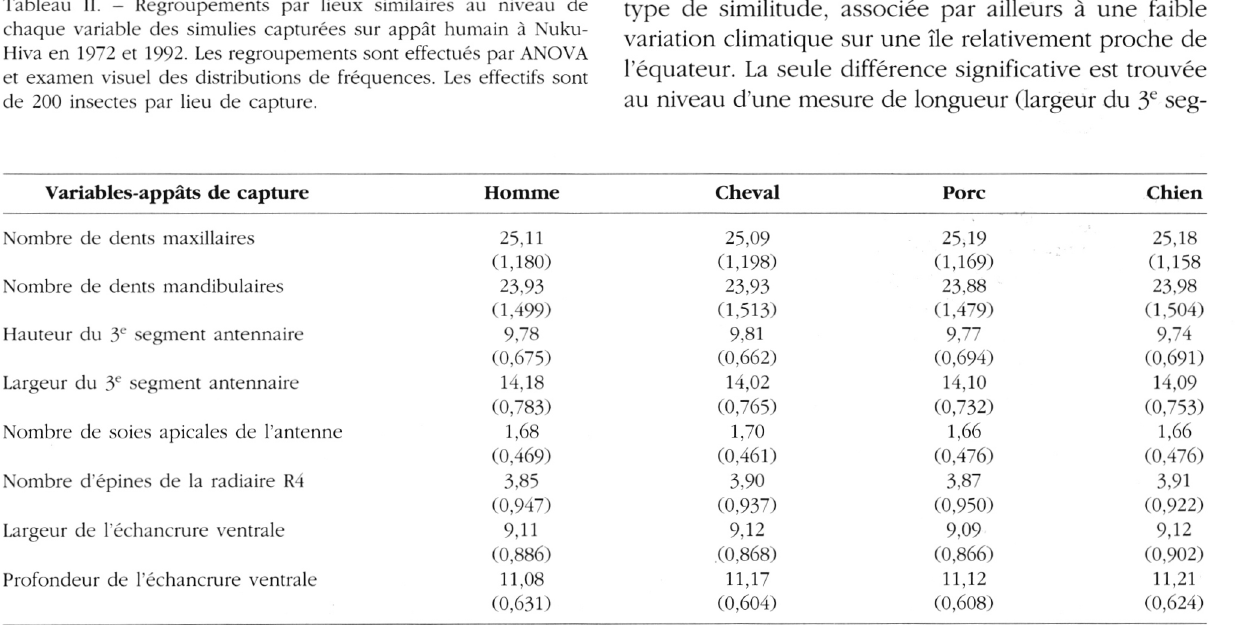
Tableau III. - Moyennes (écarts-types) des variables obtenues à partir de simulies capturées sur différents types d’appâts à Pua (Nuku- Hiva) en 1972. Les effectifs sont de 100 insectes par type d'appât. Les mesures de taille correspondent à des lectures directes au micro­ mètre et n’ont pas été converties en unités